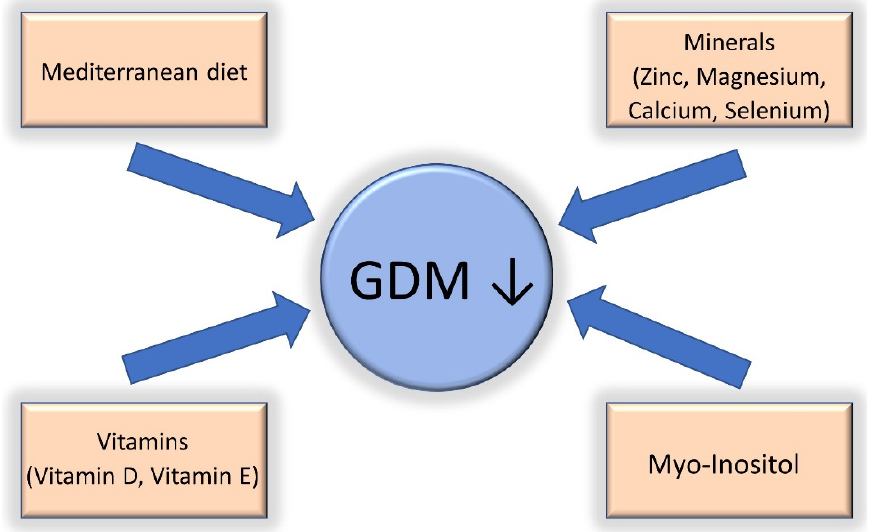
Figure 1. Nutritional interventions that have been shown to be effective in the reduction of gesta- tional diabetes (GDM). diabetes